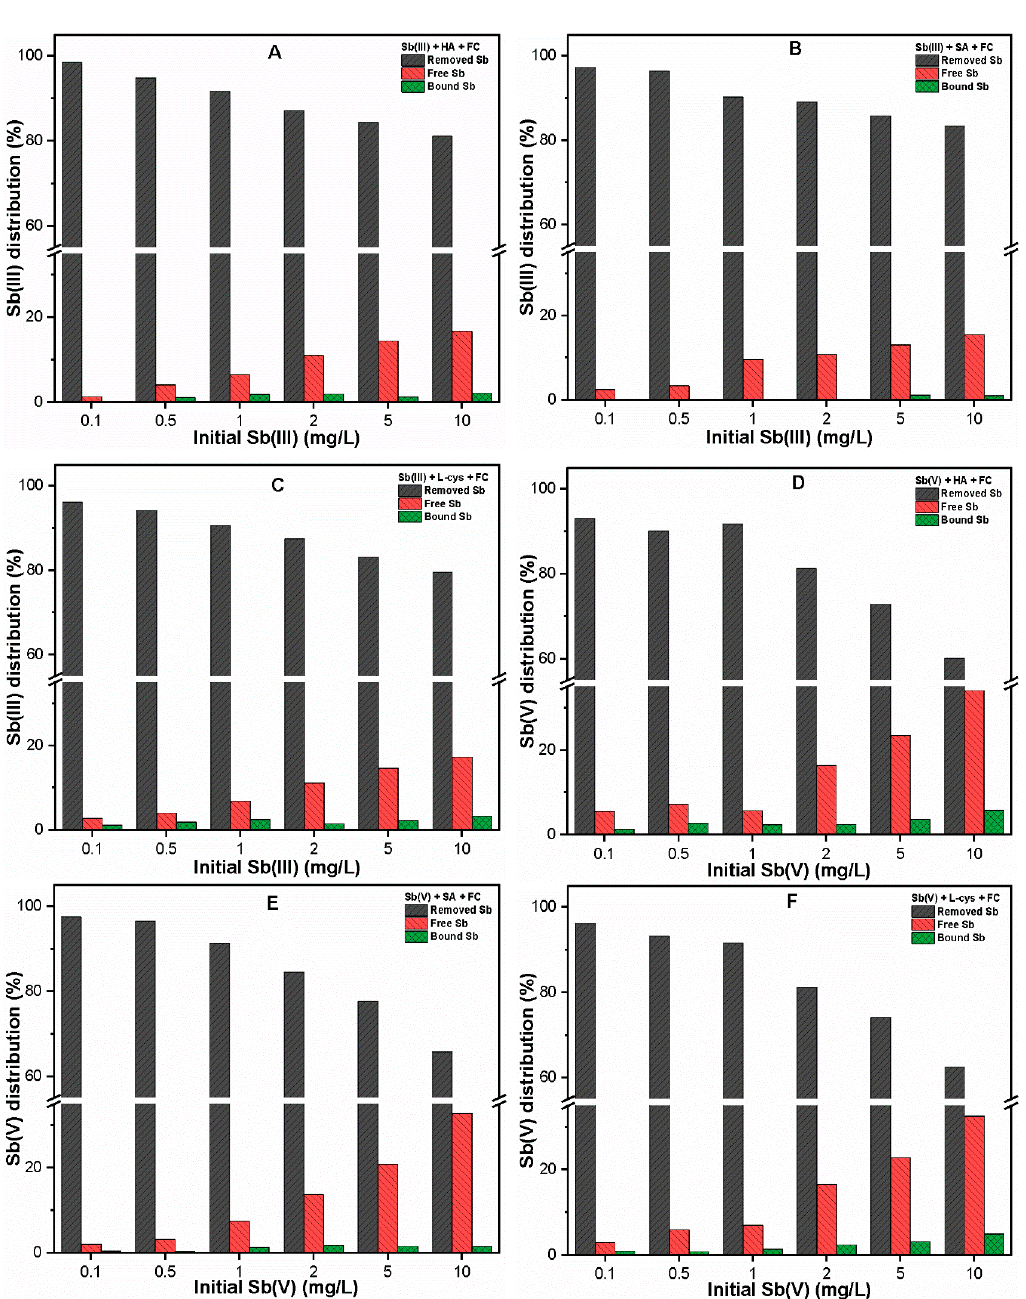
Figure 6. Percentage distributions of (A–C ) Sb(III) and (D–F) Sb(V) in NOM (10 mg/L) solutions after FC coagulation. FC